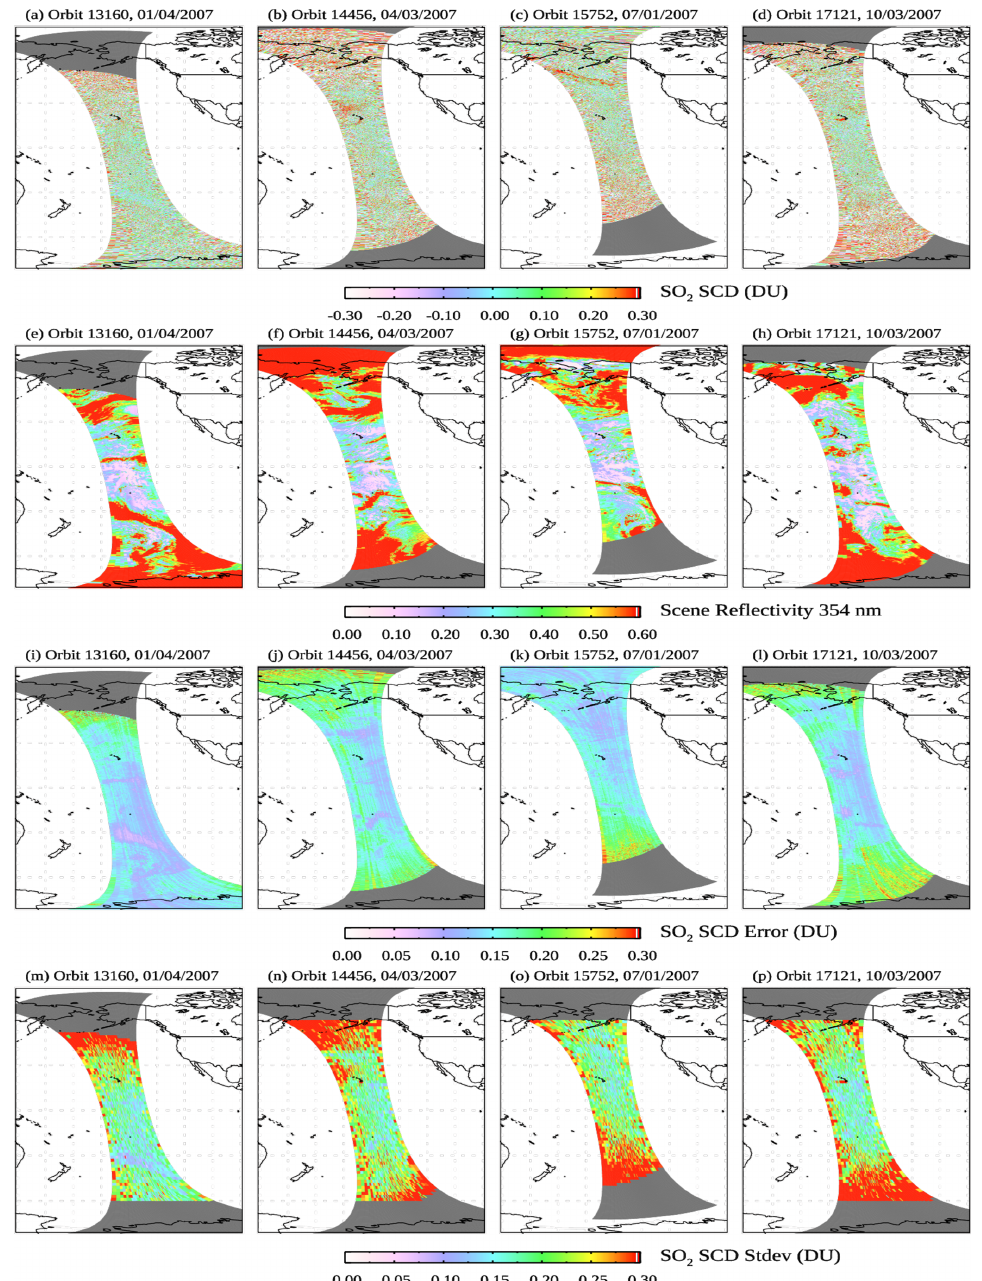
Figure 2. (a–d) The SO 2 slant column densities for four OMI swaths over the remote Pacific on (a) 4 January, (b) 3 April, (c) 1 July, and (d) 3 October 2007. (e–h) The reflectivity at 354nm for the same swaths. (i–l) Estimated uncertainties in SO 2 slant column densities ( ε SCD ) for the same swaths. Cloudy or snow/ice-covered areas have greater reflectivity and generally smaller errors in SO 2 SCDs. No retrievals were attempted for pixels with SZA > 75 ◦ that are grey-shaded. (m–p) The standard deviation of SO 2 SCDs ( σ SCD ) within 2 ◦ latitude segments of individual OMI rows for the same swaths. The spatial coverage for panels (m–p) is limited to 60 ◦ S to 60 ◦ N as changes in observation conditions tend to be larger at higher latitudes. In addition, pixels with SCD > 2DU or SZA > 75 ◦ and segments with < 10 valid pixels are excluded from the statistical